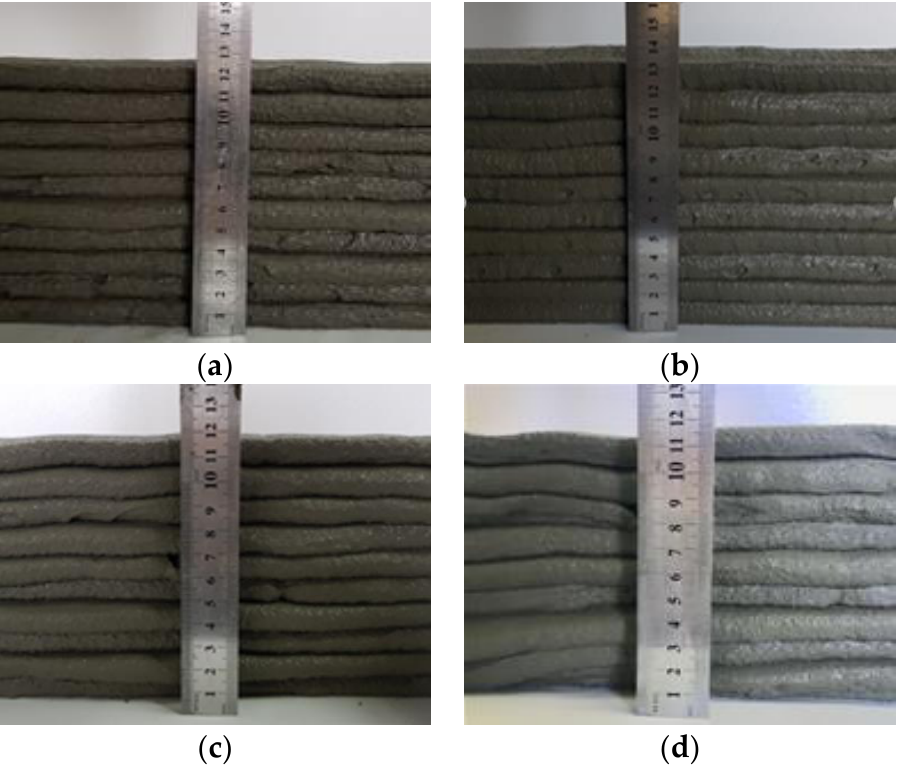
Figure 3. Test results for determining the flow with: ( a ) Flow of 60%; ( b ) Flow of 65%; ( c ) Flow of 70% and ( d ) Flow of 75%